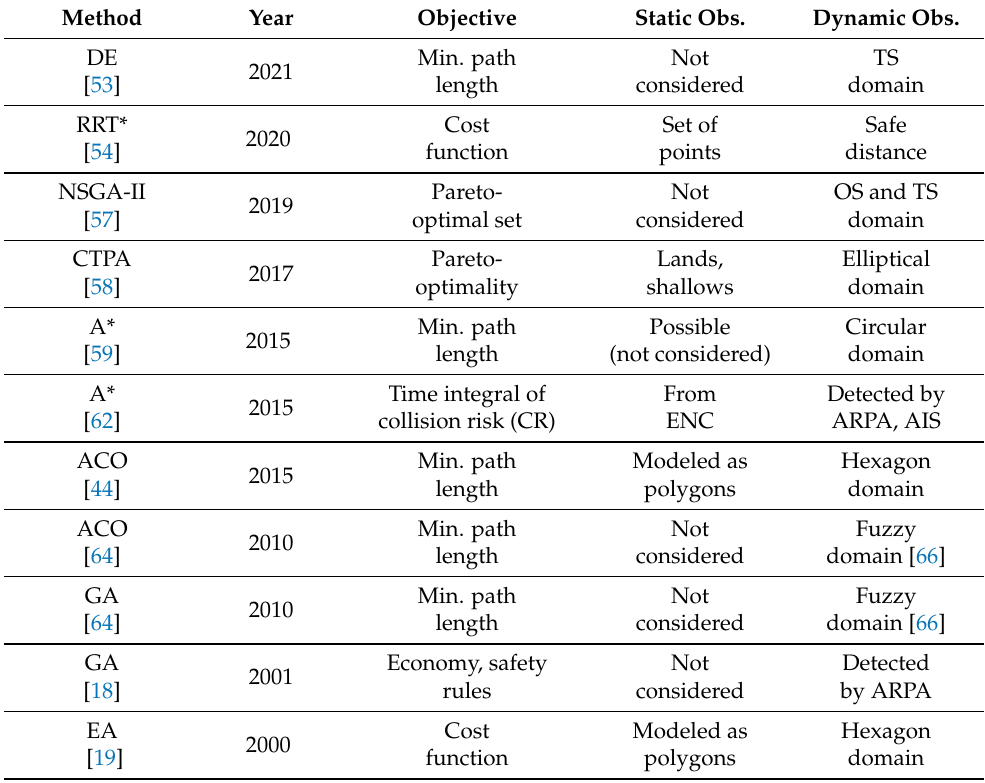
Table 6. A comparison of non-deterministic methods applying radar remote sensing and other sensors—part 1.